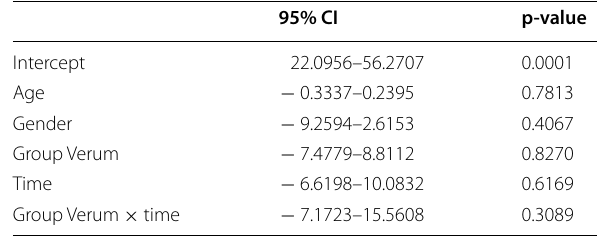
Table 10 Effect of group on SDNN, adjusted for age and